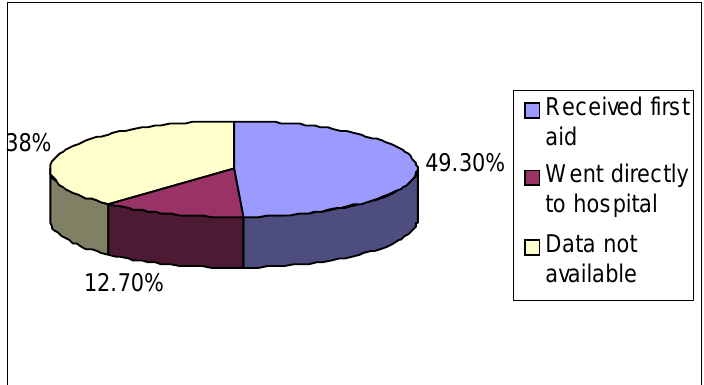
Figure 1: Percentage of patients that received first aid before hospital admission. Table 1: Qualifications of the practitioners who administered first aid after the